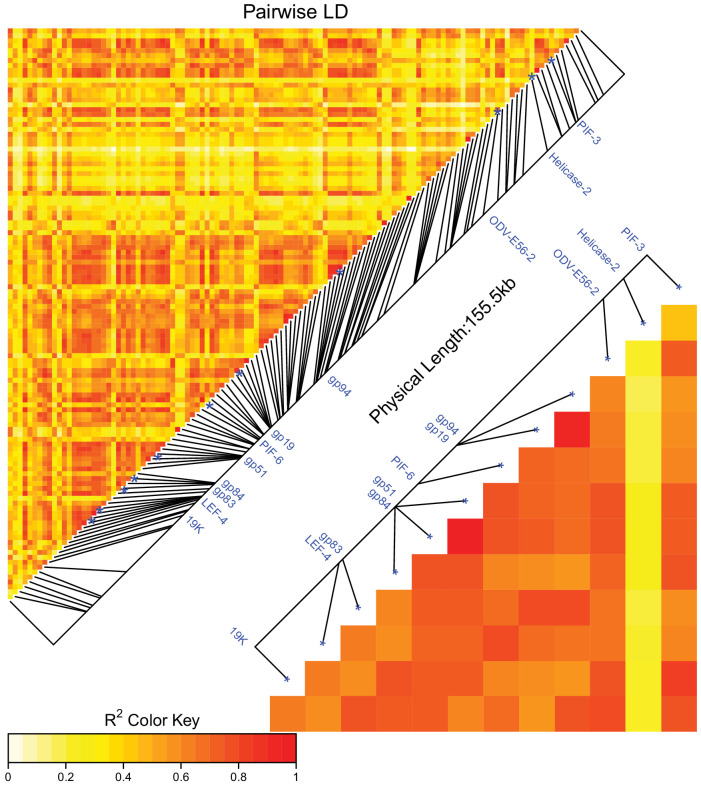
Linkage disequilibrium between SNPs in DiNV as a heatmap generated in LDheatplot.The labelled SNPs (significantly associated SNPs found in the association study) are strongly linked, shown by the high r2 between these SNPs. Points are colored by the estimated linkage between SNPs, from red (highly linked, r2 = 1) to white (unlinked, r2 = 0). Linkage disequilibrium heatmap for just the significantly associated SNPs is also shown to show the high linkage between SNPs.